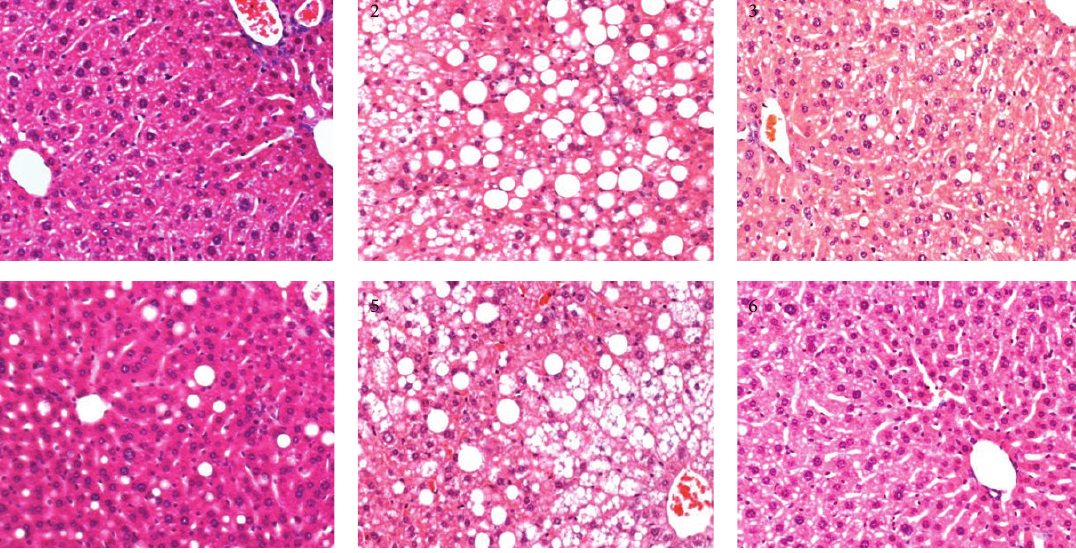
Figure 6: Representative images of H&E staining of liver sections (20x). The numbers on the upper-left corner indicate the group. The liver in Group 1 is generally normal, while obvious hepatic steatosis can be found in Group 2. Hepatic steatosis is much relieved in Group 3, 4, and 6, and that of Group 5 is slightly